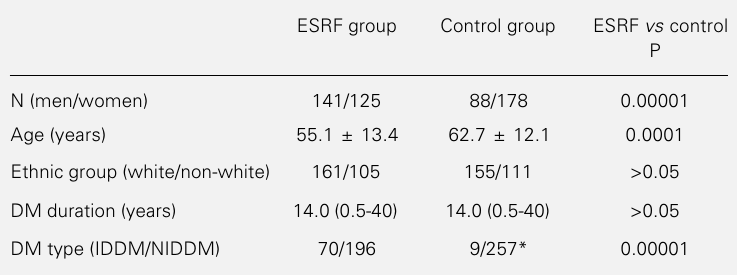
Table 1 - Characteristics of the two groups of diabetic subjects studied. Data are reported as mean ± SD or median and range. DM, Diabetes mellitus. *Three cases suspected of chronic